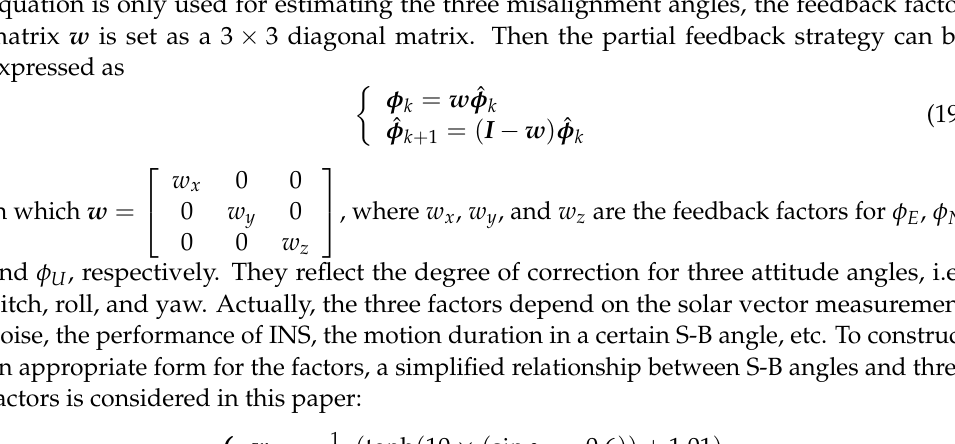
Figure 5. Integration architecture of partial feedback strategy.